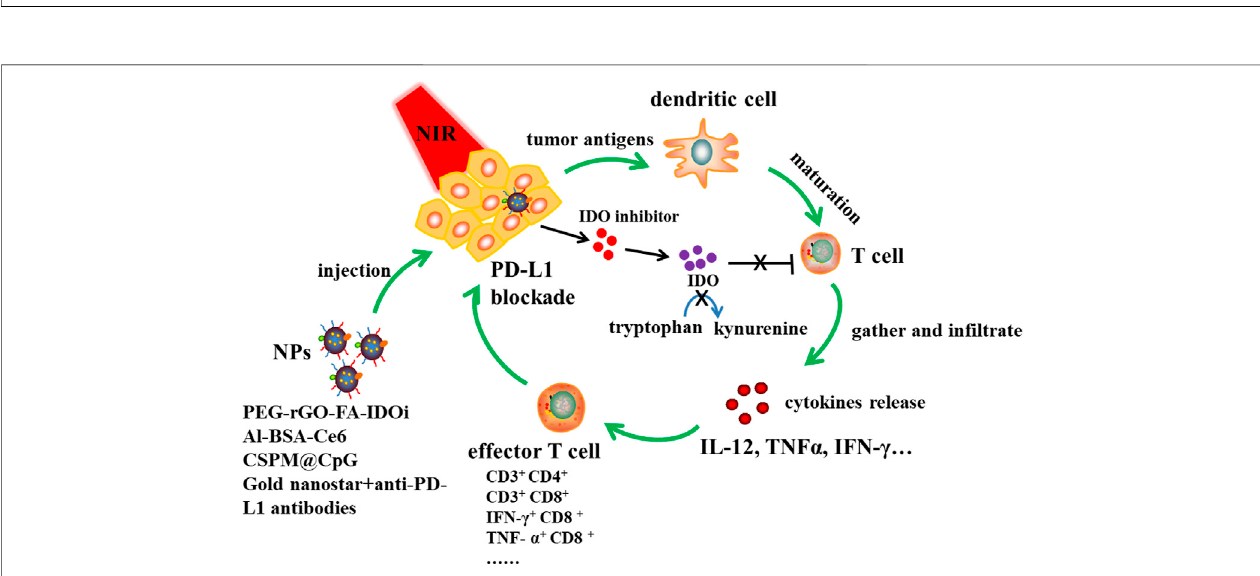
FIGURE 3 | NPs based PTT immunotherapy together with IDO inhibition and PD-L1 blockade. Designed NPs such as PEG-rGO-FA-IDOi, Al-BSA-Ce6, CSPM@ CpG, Gold nanostar-anti-PD-L1 antibodies were injected to tumor site, and then immune responses were triggered at a speci fi c light wavelength. Tumor antigens are produced,dendriticcellsarematuratedintoTcells,thenTcellsgatherandin fi ltratetumorsite,promotingcytokinesreleaselikeIL-12,TNF α andIFN- γ toincreaseeffctor T cells proportion. NPs release IDO inhibitor, which could inhibit IDO converting tryptophan to kynurenine. This was bene fi cial to T cell proliferation. What ’ s more, NPs combined with anti-PD-L1 antibodies could induce PD-L1 blockade and then enhance immune response to kill tumor cells.